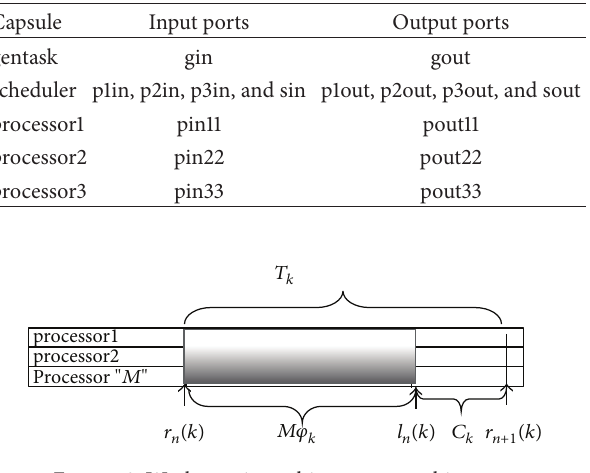
Figure 2: Work area in multiprocessor architecture.